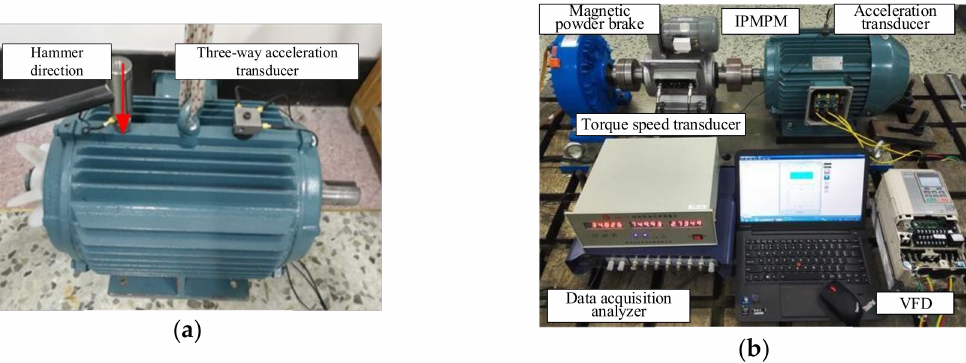
Figure 2. The laboratory test platform. ( a ) Modal test; ( b ) Vibration